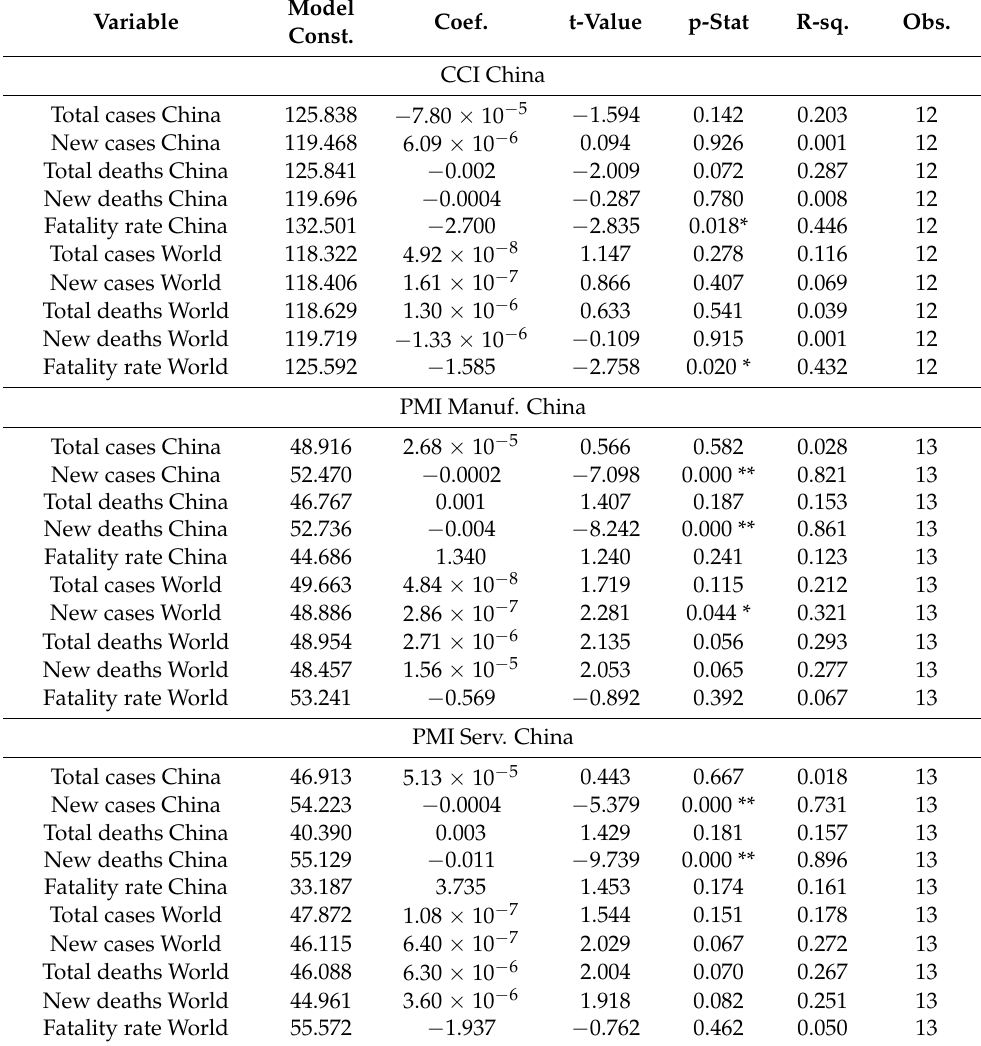
Table 6. Regression models for COVID-19’s effect on China economic-sentiment indicators. Variable